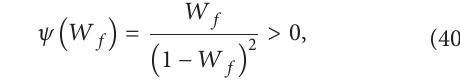
Aer the analysis of the system stability, bioprocess optimization was covered in the work. In the �rst